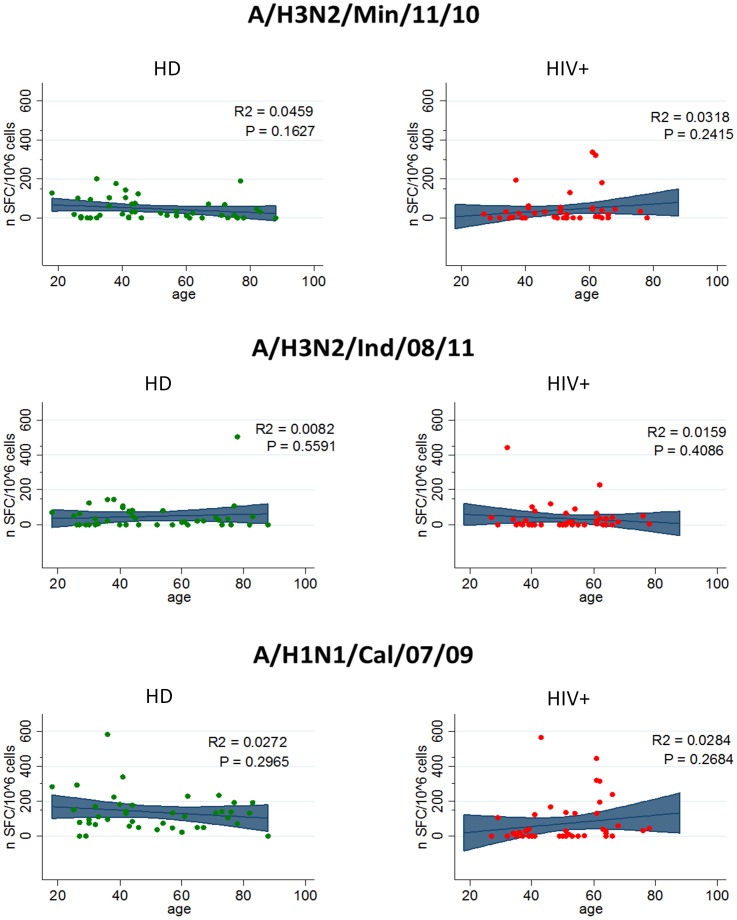
Association between age and cellular immune response to different influenza A virus strains.The potential and the shape of association between age and T-cell response against A/H3N2/Min/11/10, A/H3N2/Ind/08/11 and A/H1N1/Cal/07/09 is shown for HD (left panels) and HIV+ (right panels) was analyzed by linear regression model. Departure from linear trend was assessed by model based likelihood ratio test (LTR) to assess the model including age as polynomial predictor.